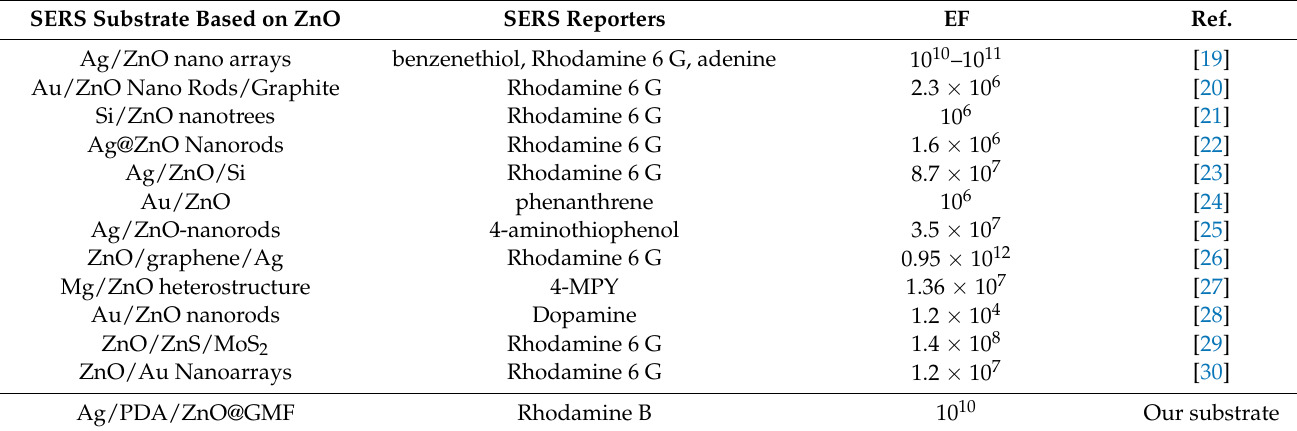
Table 1. ZnO based SERS substrates developed in the past few